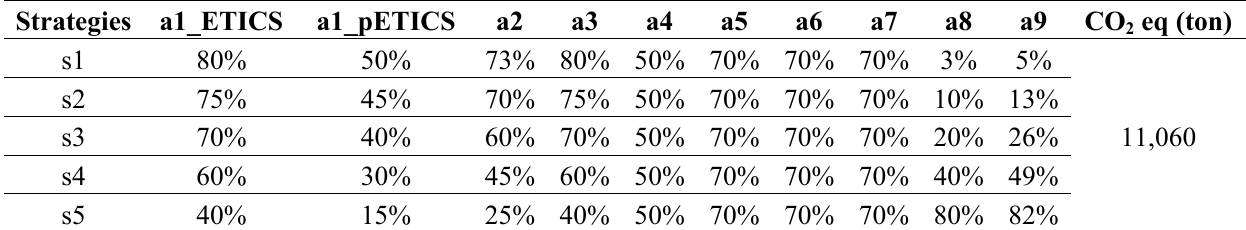
Table 3. Application percentages for intervention in five energy retrofit